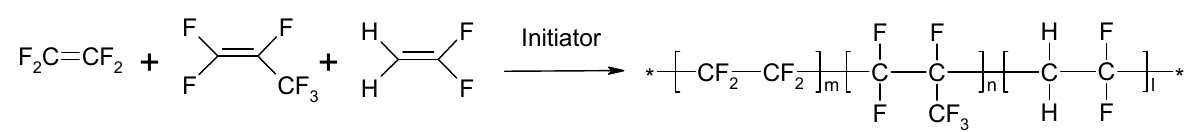
Figure 12. The preparation of